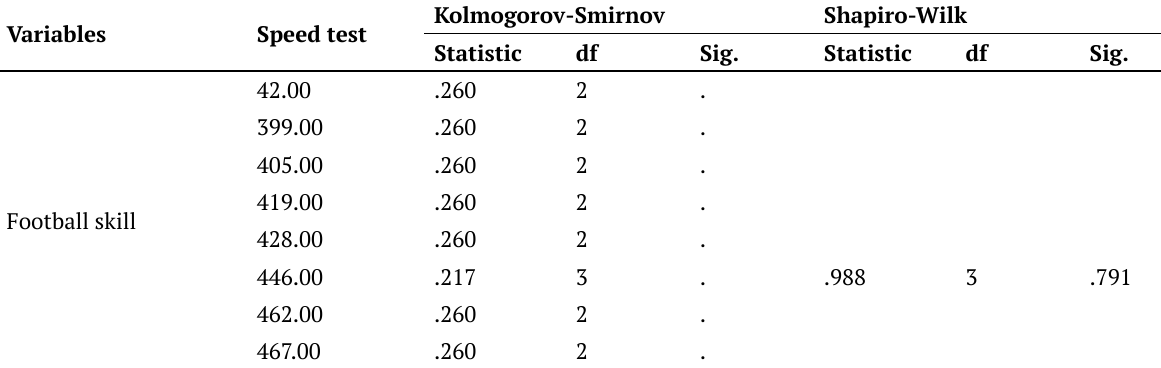
Table 3. Normality Test’s Result Variables